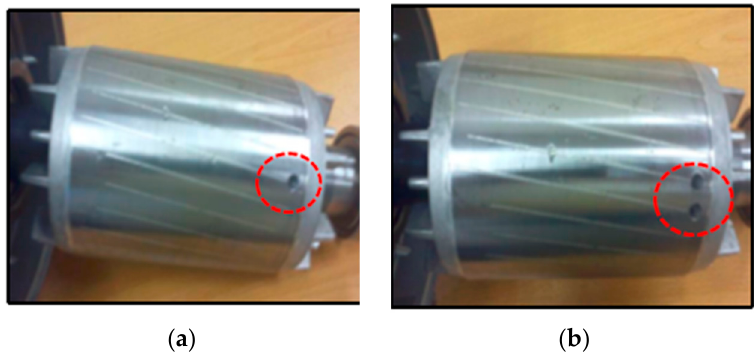
Figure 5. The different induction motors with ( a ) 1 BRB, and ( b ) 2 BRBs fault.